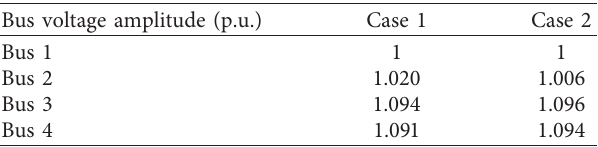
Table 3: The voltage level of the system at T � 8 when the sample size is